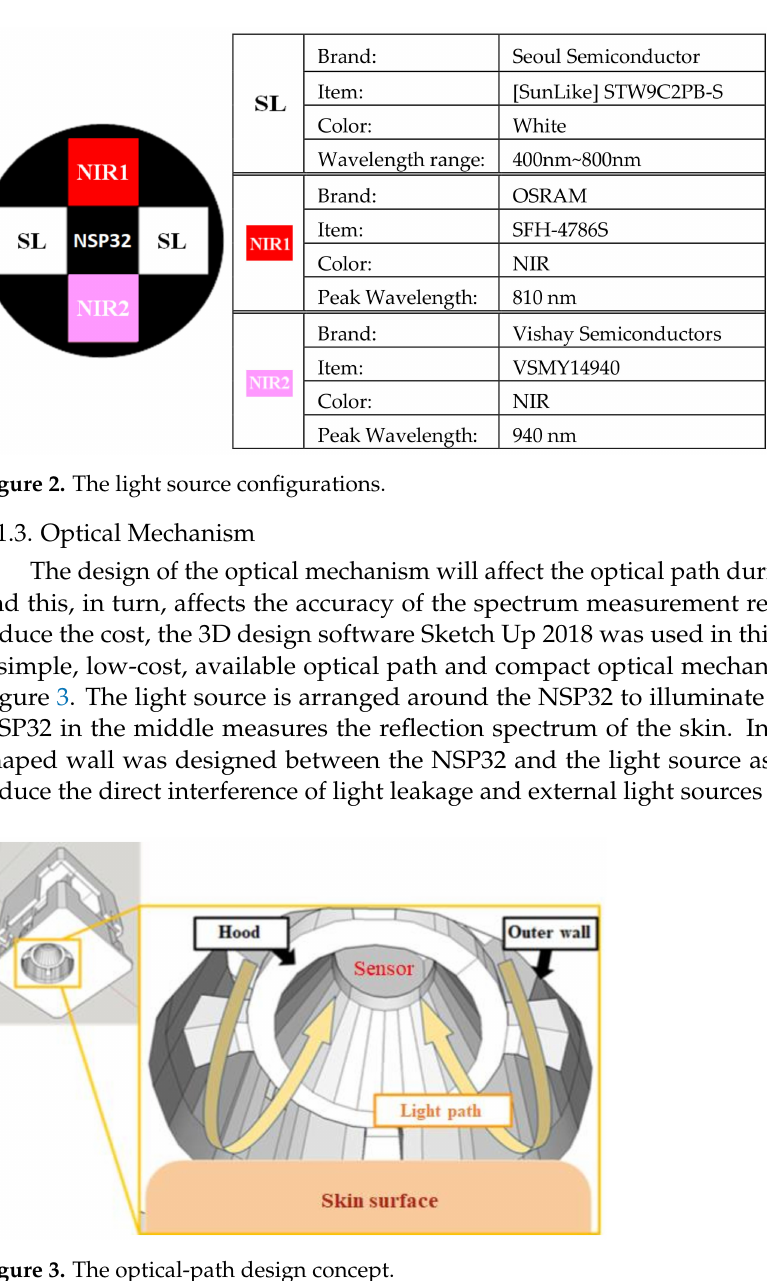
Figure 3. The optical-path design